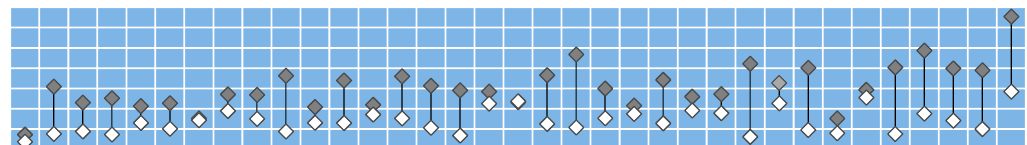
Figure 1. Standardized mortality rates due to lung cancer among Organization for Economic Cooperation and Development (OECD) countries, in 2017 or the latest available. Source: International Agency for Research on Cancer (IARC), GLOBO- CAN